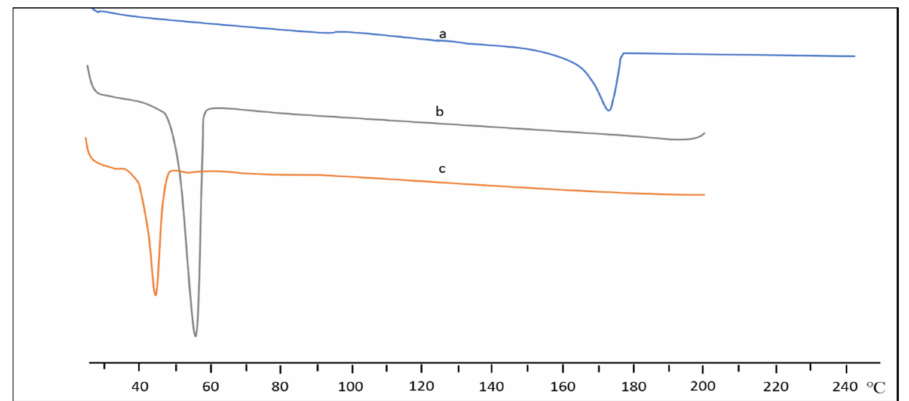
Figure 4. DSC thermogram of (a) CUR (b) mPEG-PCL, and (c) CUR/mPEG-PCL micelles. Reprinted/adapted with permission from Elsevier